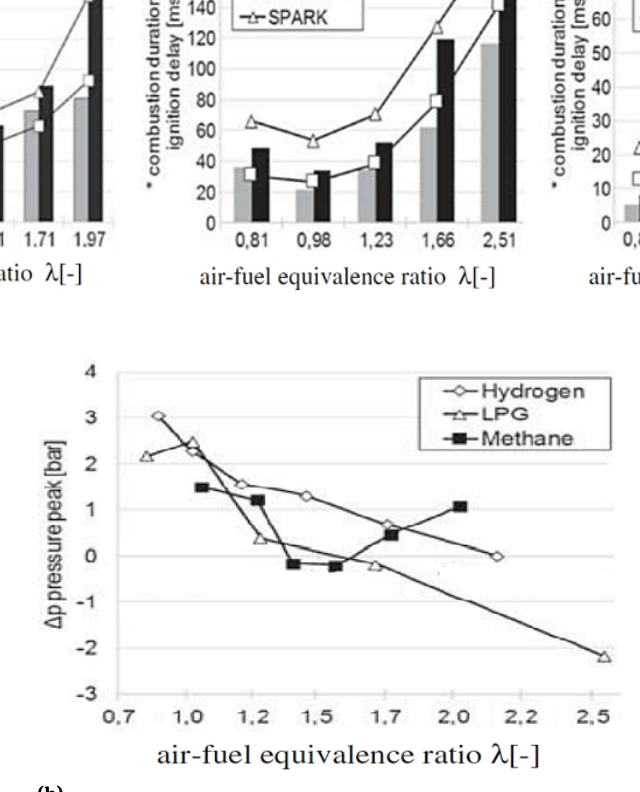
Figure 8: Histograms related to the comparison between combustion duration and ignition delay deriving by the use of nano-particles or spark-plug (a) and graph related to pressure peak obtained with the two ignition system (b) for all the tested fuels